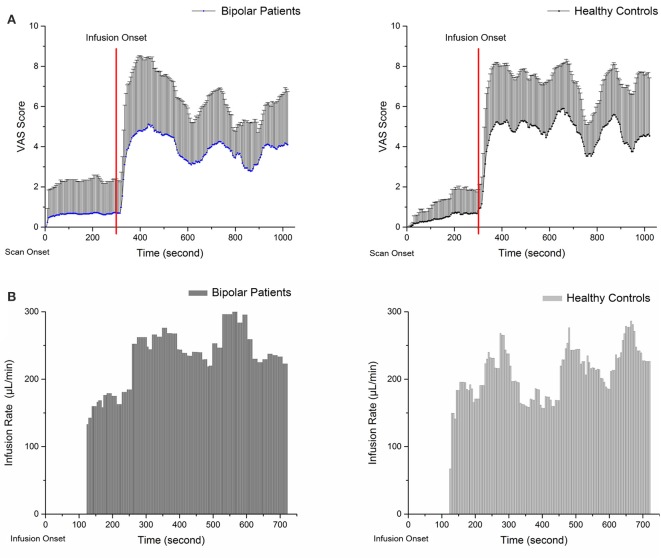
Panels (A,B) show the VAS scores and average infusion rate of subjects during pain session. The VAS scores were recorded from the start of the scan. (A) Zero to three hundred second is baseline scanning; functional scanning began at 300 s and was completely synchronized with injection. The average infusion rate was recorded from the start of injection. (B) At the onset of infusion, a standard 0.2 mL bolus of 5% hypertonic saline solution was administered over 15 s as a tonic muscle pain stimulus; at 120 s, infusion based on VAS score was started.